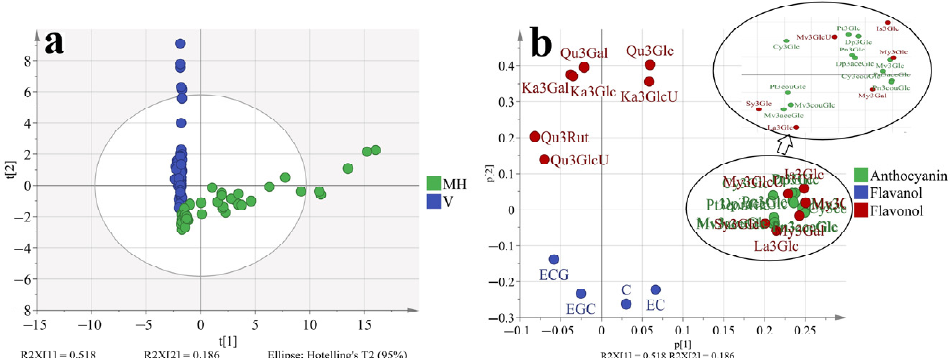
Figure 4. PCA ( a , score plot; b , loading plot) based on the concentration of individual phenolic compounds in ‘Muscat Hamburg’ grapes and ‘Victoria’ grapes in 2014 and 2015 under the double cropping system. Dp3Glc, delphinidin-3- O -glucoside; Cy3Glc, cyanidin-3- O -glucoside; Pt3Glc, petunidin-3- O -glucoside; Pn3Glc, peonidin-3- O -glucoside; Mv3Glc, malvidin-3- O -glucoside, Dp3aceGlc, Delphinidin-3- O -acetyl-glucoside; Pn3aceGlc, peonidin-3- O -acetylglucoside; Mv3aceGlc, malvidin-3- O -acetyl-glucoside; Cy3couGlc, cyanidin-3- O -coumaryl-glucoside; Pt3couGlc, petunidin-3- O -coumaryl-glucoside; Pn3couGlc, peonidin-3- O -coumaryl-glucoside; Mv3couGlc, malvidin-3- O -coumarylglucoside; My3GlcU, myricetin-3- O -glucuronide; My3Gal, myricetin-3- O -galactoside; My3Glc, myricetin-3- O -glucoside; Qu3Gal, quercetin-3- O -galactoside; Qu3GlcU, quercetin-3- O -glucuronide; Qu3Rut, quercetin-3- O -rutinoside; Qu3Glc, quercetin-3- O -glucoside; La3Glc, laricitrin-3- O -glucoside; Ka3Gal, kaempferol-3- O -galactoside; Ka3GlcU, kaempferol-3- O -glucuronide; Ka3Glc, kaempferol-3- O -glucoside; Is3Glc, isorhamnetin-3- O -glucoside; Sy3Glc, syringetin-3- O -glucoside; ECG, epicatechin-3- O -gallate; EGC, epigallocatechin; C, catechin; EC, Epicatechin. To better discriminate the effect of different growing seasons on grapes phenolic profiles. The OPLS-DA model was used which had a better focus toward the studied objective than PCA, as shown in Figure 5. The model has passed 200 permutation tests (Supplementary Figure S2), indicating good fit and predictive abilities. Results showed that the samples from the summer and winter seasons could be separated better than in Supplementary Figure S1b. In the S-plot (Figure 5b), most phenolic compounds were located on the first quadrant of the coordinate axis except for EGC. So it was confirmed that the winter berries had more abundant phenolic compounds irrelevant with varieties or other factors. The peonidin-3- O -glucoside contributed the highest variation in all phenolic compounds. In the winter berries, the peonidin-3- O -glucoside was at least 8 folds higher than in summer berries, which was shown in Table 2. For epigallocatechin, there was no significant difference between summer and winter